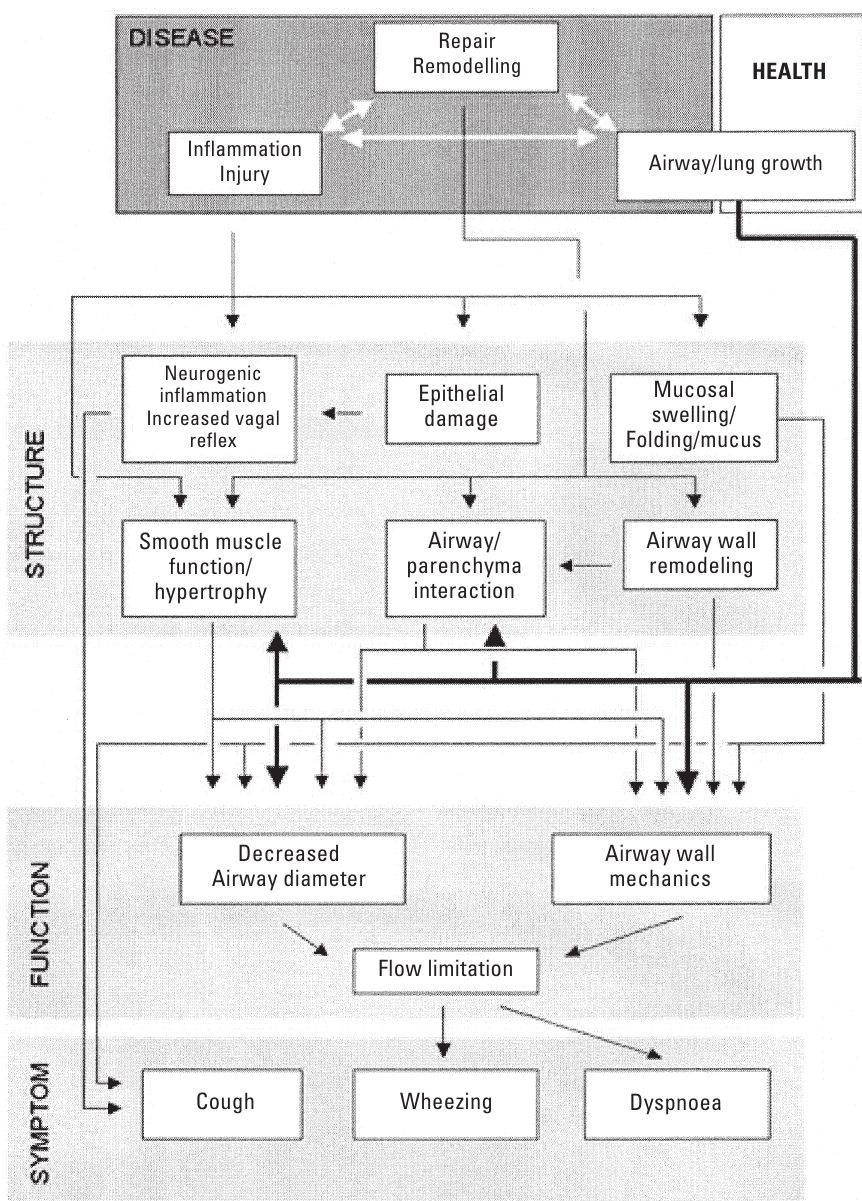
Repair Remodelling HEALTH